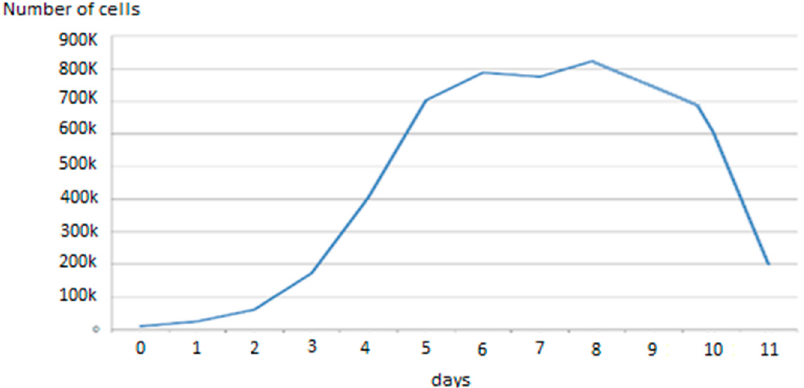
Figure 3. Growth curves obtained by traditional methods (cell cultures without di ff erentiation). No significant di ff erence between this cell culture and the cell cultures monitored on the 8W10E PET cultureware was found.